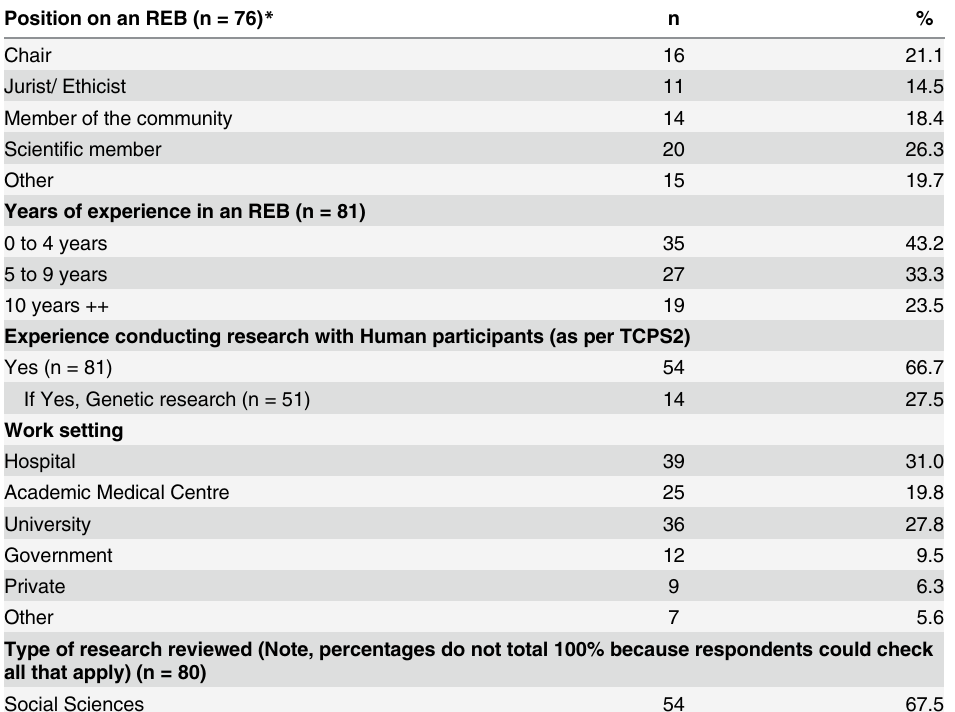
Table 1. Participants ’